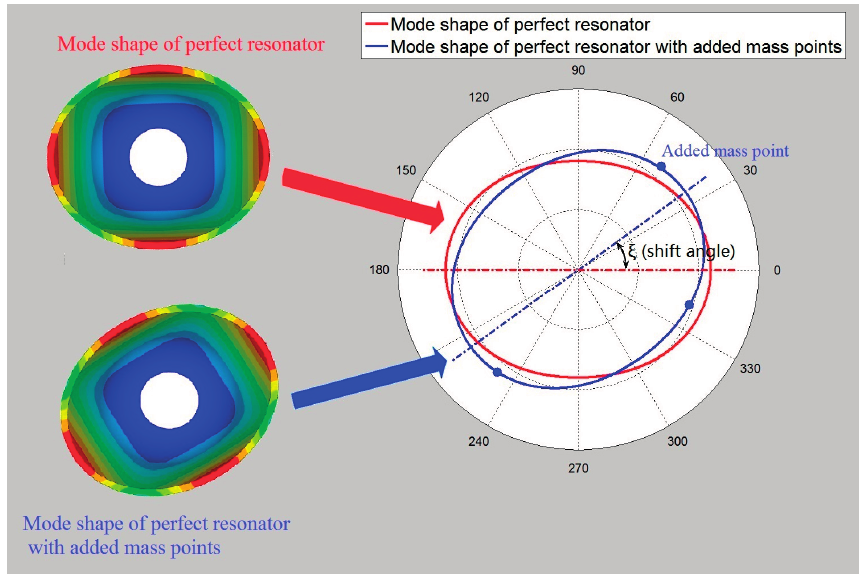
Figure 4. The contrast between the mode shape of a perfect resonator with and without added mass